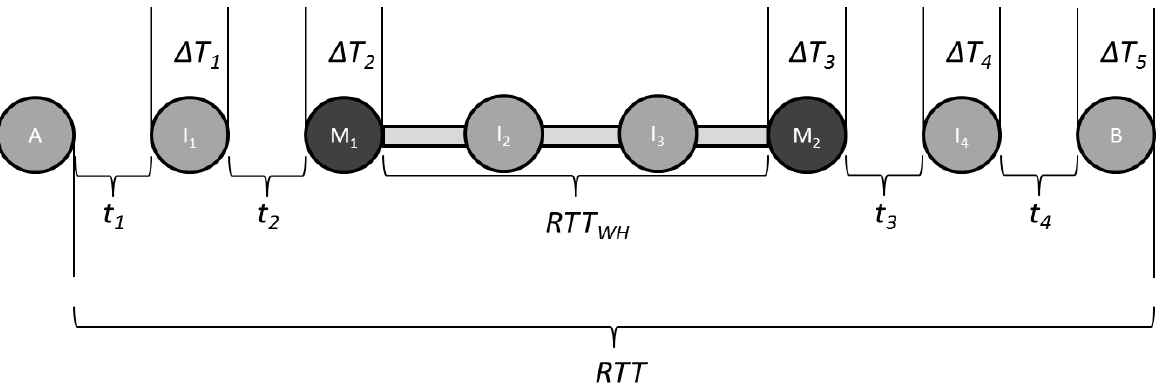
Figure 1. MANET scenario where A and B are the source and destination nodes, M M are malicious wormhole nodes, t 2 routing packet processing time, RTT is the round trip time of the route, and RTT RTT of the wormhole